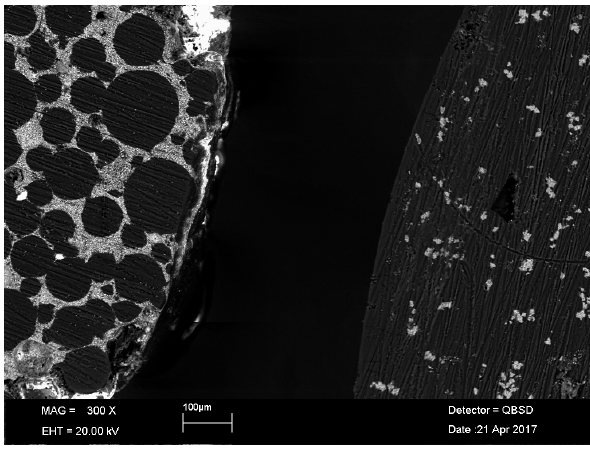
Figure 8. Sections of both cements analyzed in an SEM. Left: BS-cement, Right: CC-cement.